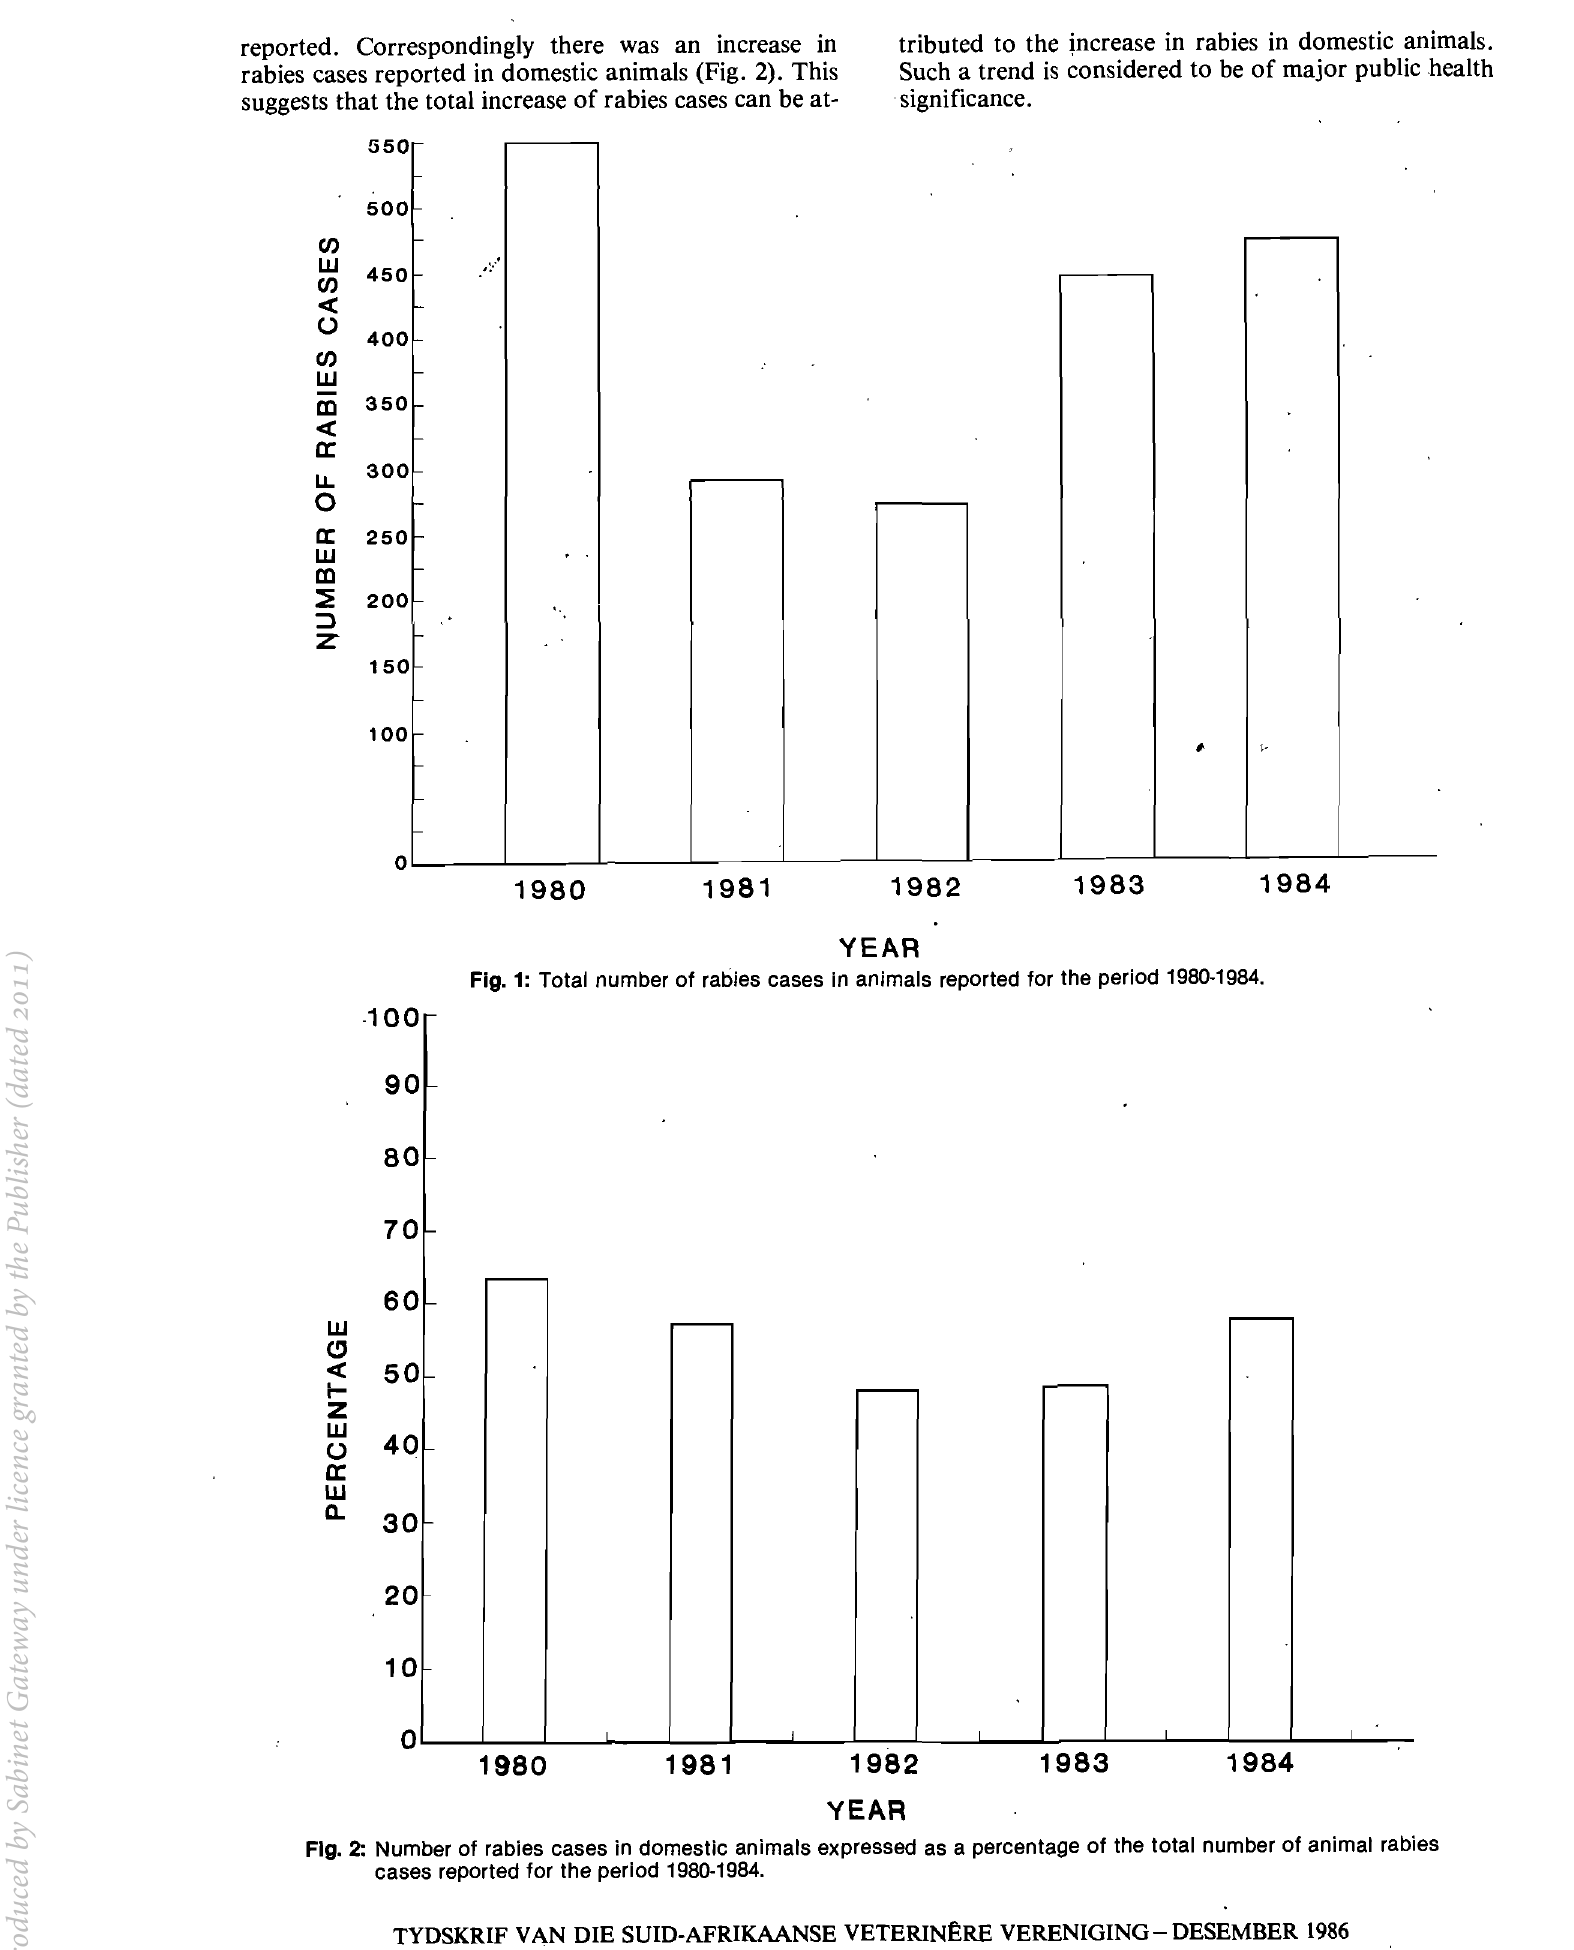
Fig. 2: Number of rabies cases in domestic animals expressed as a percentage of the total number of animal rabies cases reported for the period 1980-1984. TYDSKRIF V AN DIE SUID-AFRIKAANSE VETERINERE VERENIGING - DESEMBER